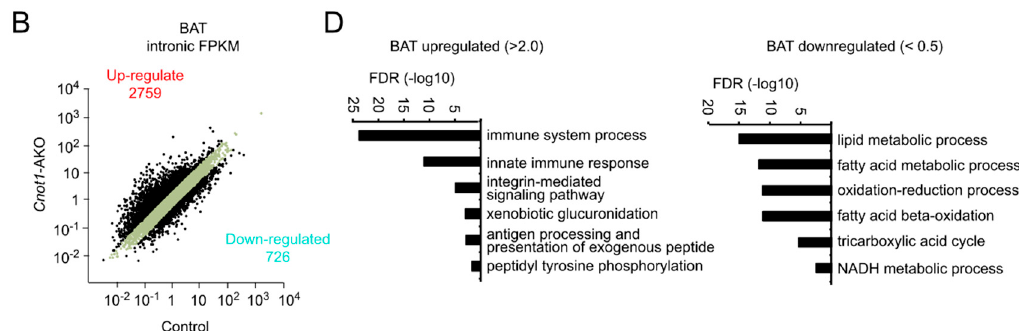
Figure 6. Changes in pre-mRNA abundances are responsible for gene expression differences between control and Cnot1 -AKO mice. ( A,B ) Scatter plots of intronic fragments per kilobase of exon per million mapped sequence reads (FPKMs) in iWAT ( A ) and BAT ( B ) of 12-week-old control and Cnot1 -AKO mice ( n = 4). Black dots represent pre-mRNAs whose expression differed more than two-fold in Cnot1 -AKO mice compared to controls. ( C,D ) GO enrichment analysis of genes showing intronic FPKMs that increased or decreased more than two-fold in iWAT ( C ) and BAT ( D ) of 12-week-old Cnot1 -AKO mice. Bar charts of the BP GO terms (at most six) ranked by FDR (<0.05) are shown. Note that no significant enrichment of the BP GO terms occurred for increased pre-mRNAs in iWAT. Gene lists included in each GO term are summarized in Supplementary Tables S5 and S6.